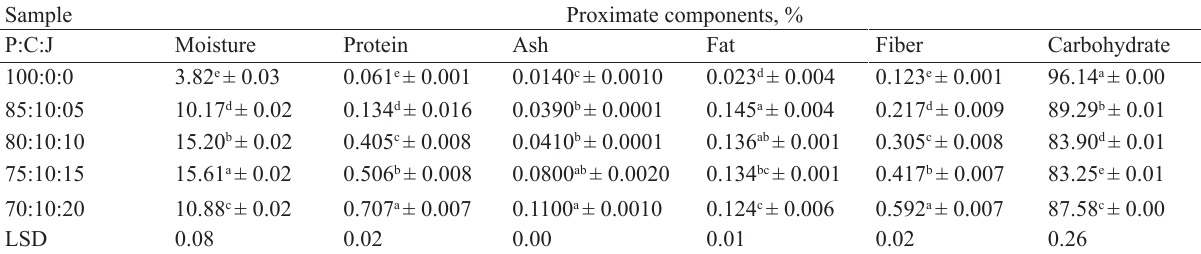
Table 4 Proximate components in pineapple jam with cucumber and Jatropha leaf in different proportions Sample Proximate components, %